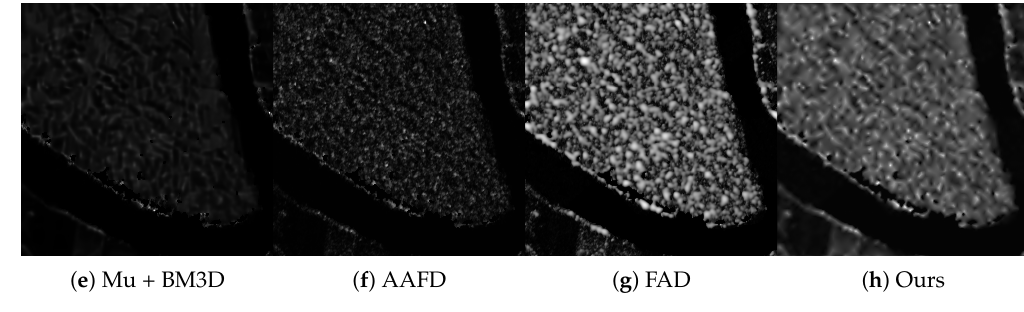
Figure 12. Denoised results.